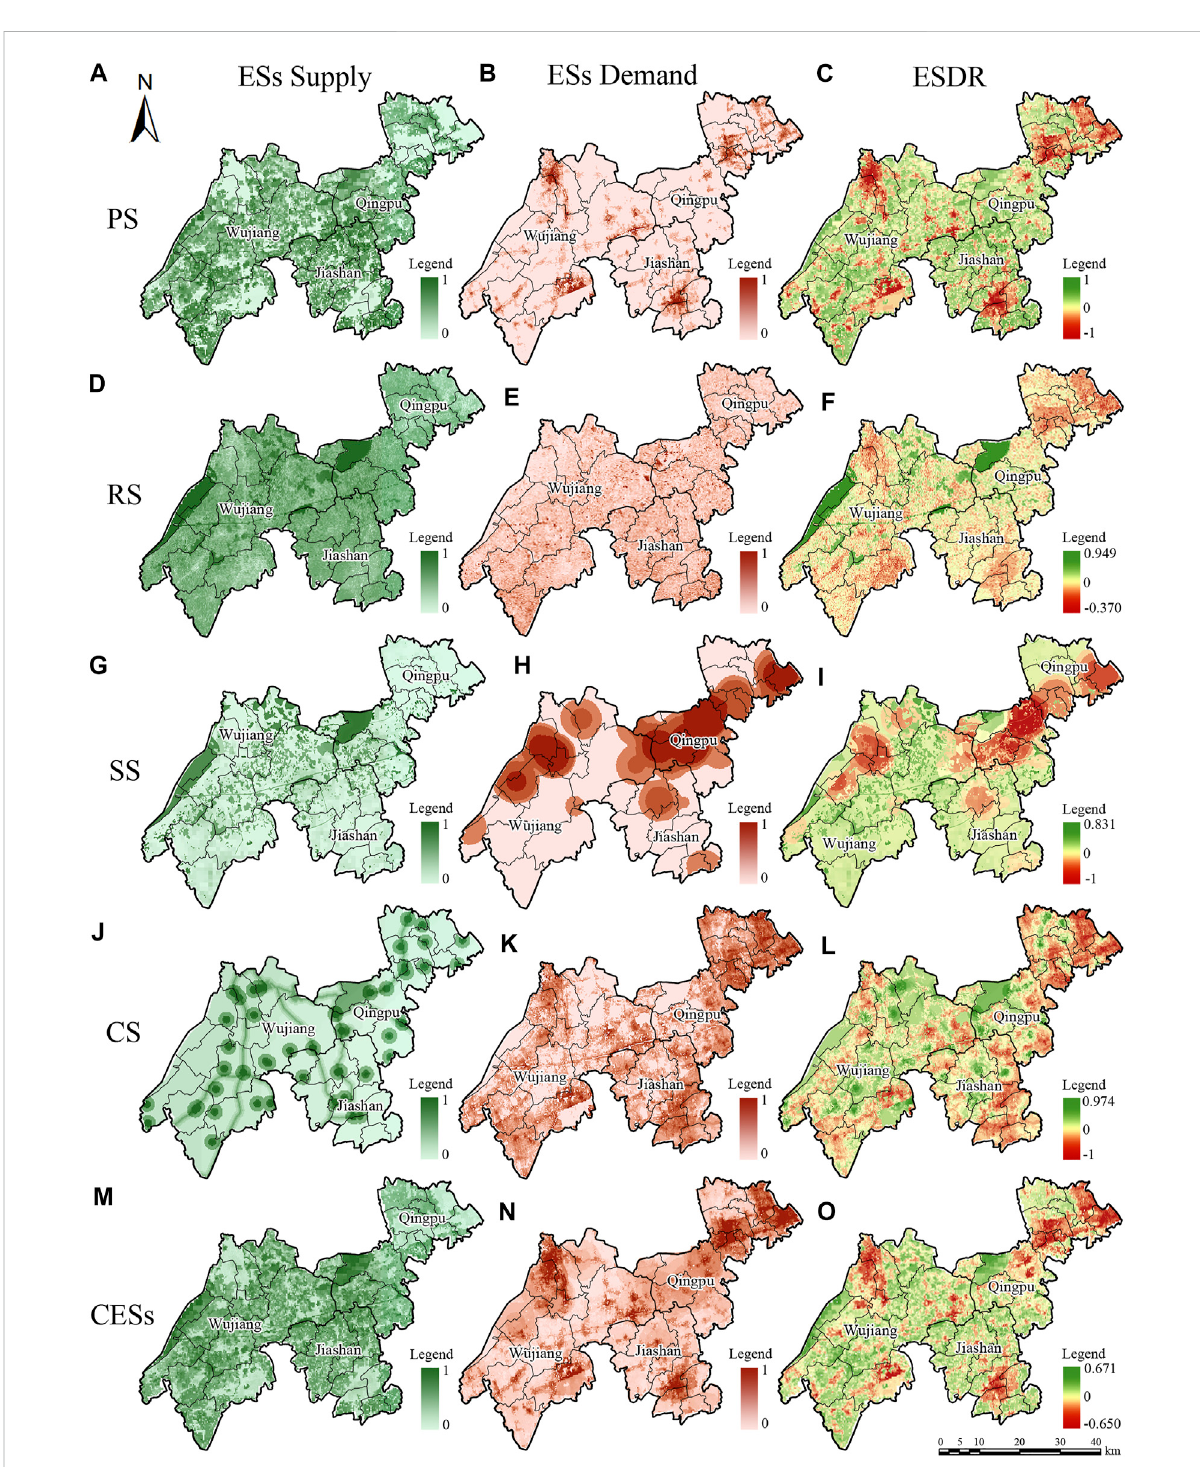
FIGURE 3 SpatialdistributionofESsupply,demand,andESDR. (A) PSsupply; (B) PSdemand; (C) ESDRforPS; (D) RSsupply; (E) RSdemand; (F) ESDRforRS; (G) SS supply; (H) SS demand; (I) ESDR for SS; (J) CS supply; (K) CS demand; (L) ESDR for CS; (M) CESs supply; (N) CESs demand; (O) ESDR for CESs. (PS:provisioning service; RS: regulating service; SS: supporting service; CS: cultural service; CESs: comprehensive ecosystem services; ESDR: ecological supply-demand